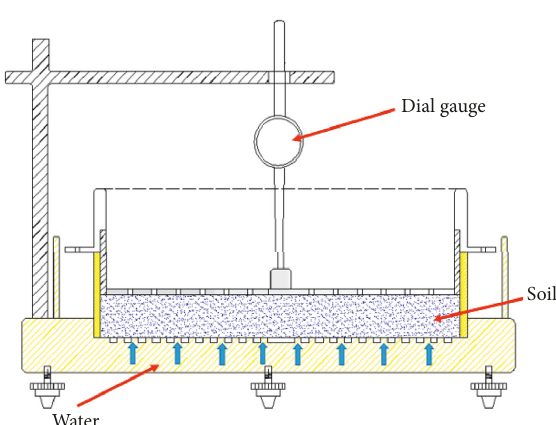
Figure 2: The diagram of unloading swelling ratio test.